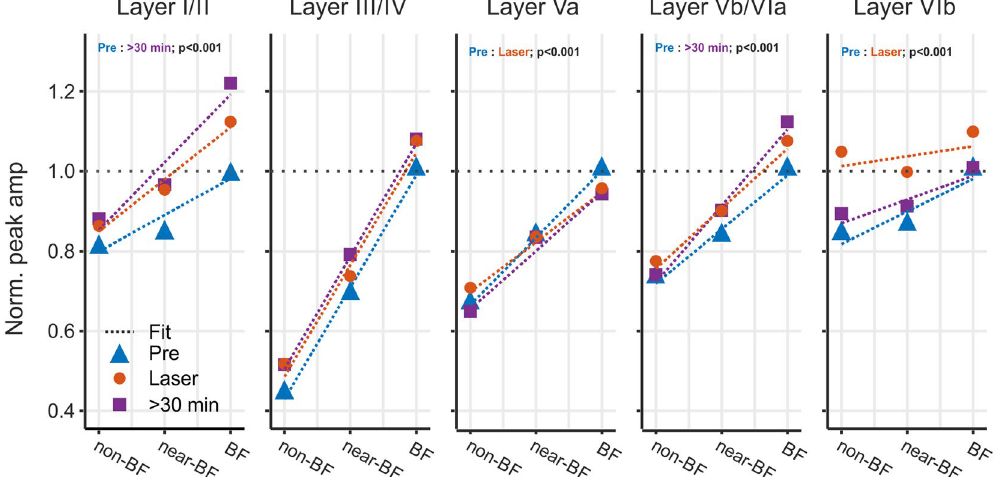
Figure 4. Layer-specific early and late changes of tuning sharpness of the C1V1 group For data from the C1V1 group, peak amplitudes within each layer were normalized to BF-responses before laser stimulation. We fitted a linear fit (dashed lines) across evoked responses across the BF-, near-BF- and non-BF-bins and calculated the slope as indicator for spectral tuning sharpness (for pre, laser, > 30 min). Sharpest tuning properties of peak amplitudes were found in layers III/IV (slope of 0.28). Tuning in layers III/IV was not affected by VTA stimulation. Layers I/II showed less prominent tuning revealed by a shallower slope in the pre-condition. While VTA stimulation did not yield an immediate significant difference, slopes indicated a significantly sharper tuning > 30 min after VTA stimulation (p < 0.01). This was due to mainly an increase in BF-evoked peak amplitudes in accordance with Fig. 5. Peak amplitudes in infragranular layers Vb/VIa showed a similar effect as layers I/II with a trend of sharper tuning during VTA stimulation that yielded significance > 30 min later. In contrast, only in late infragranular layer VIb, peak amplitudes revealed a significantly shallower slope indicative of a broader frequency tuning during laser stimulation (Pre: laser; p < 0.01), which recovered after > 30 min (Pre: < 30 min; p = 0.1). This can be seen by the flat slope between non- and BF bins. Layer Va only showed a minor decrease of the slope during VTA stimulation that recovered partially > 30 min later. Significances indicated are based on slope comparisons performed using the Ismeans package in R (version 2.27–62). For statistical explanation, see